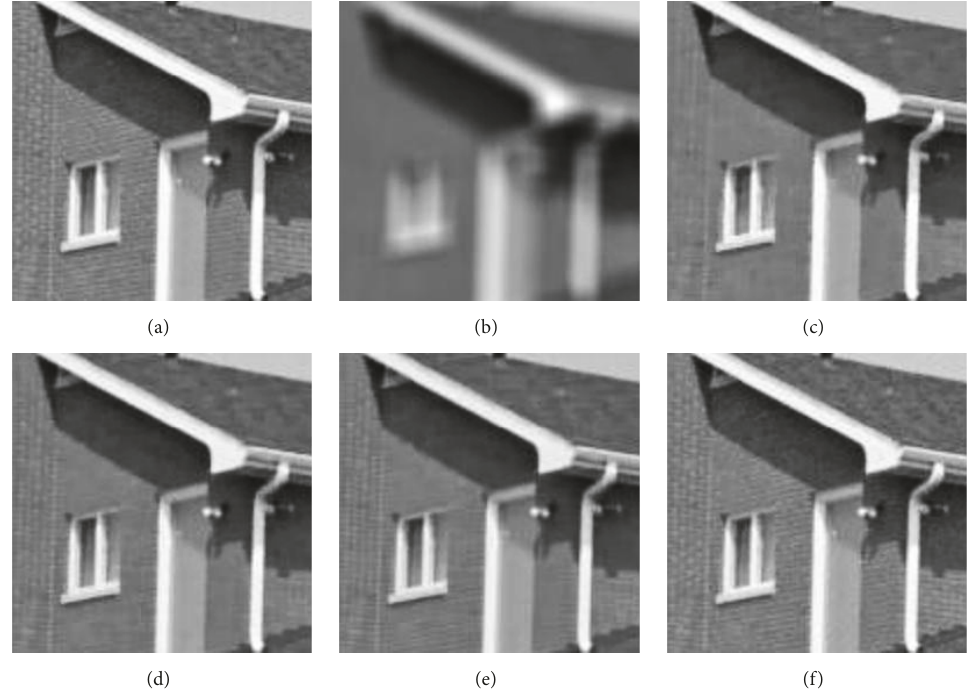
Figure 6: The zoomed regions of the results of Figure 5. (a) Original image; (b) blurred and noisy image; (c) image deblurred by FTVd; (d) image recovered by TGV; (e) image recovered by TVframe; (f) image recovered by